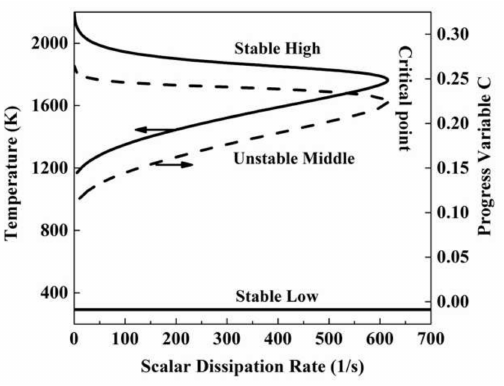
Figure 1. The locus of the maximum temperature and maximum progress variable C from a complete flamelet library (including the unstable